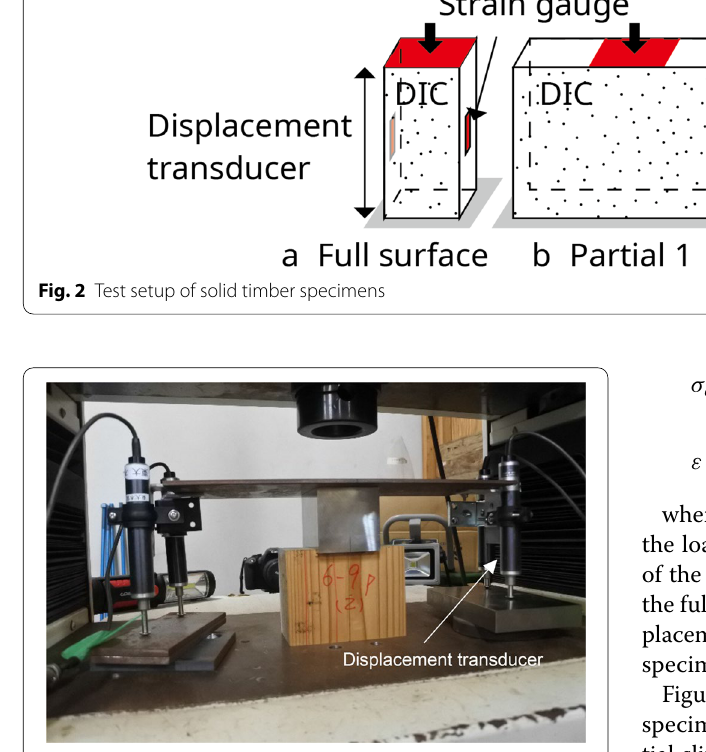
Fig. 3 Test measurements of solid timber specimen (6-9p in Table